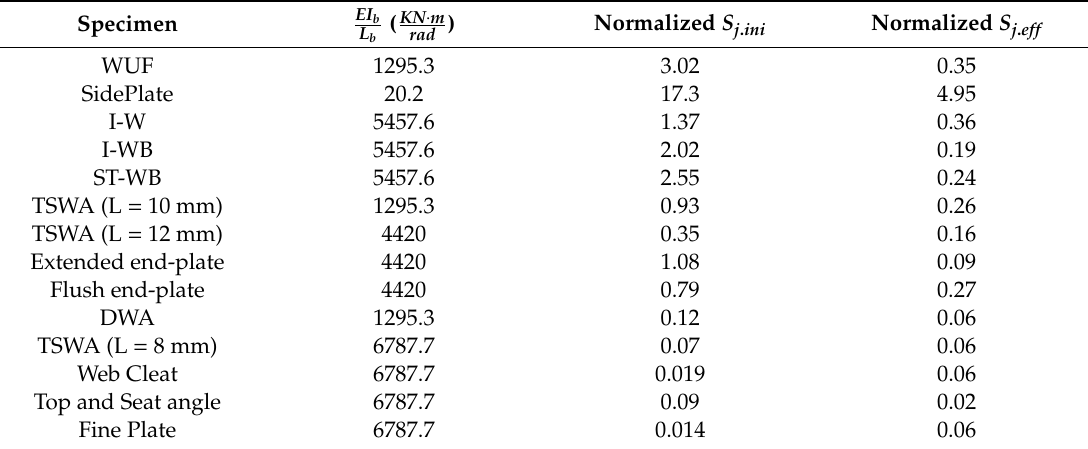
Table 6. Sti ff ness Properties of the Studied